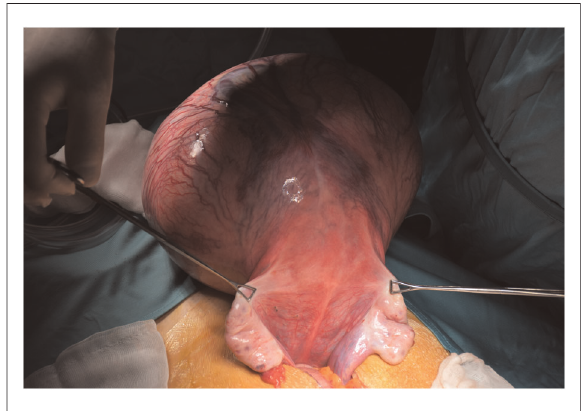
FIGURE 2 Intraoperative image showing the suture of the fundus and the fi nal aspect of the